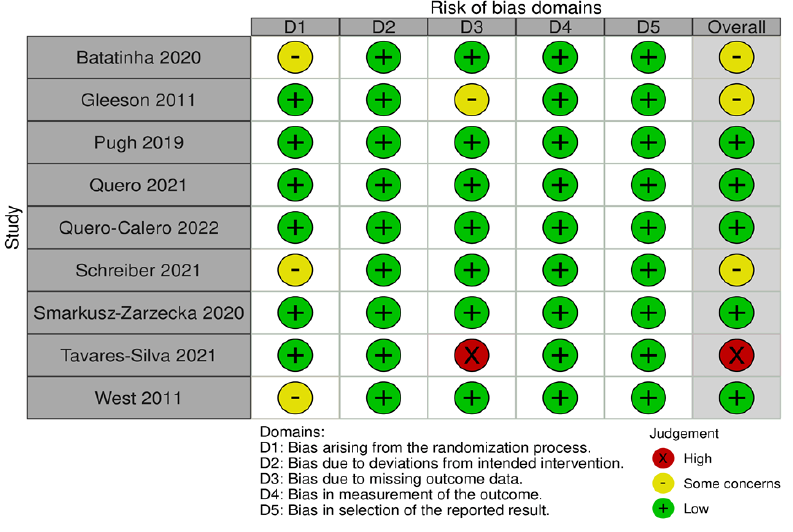
Figure 2. Flowchart of the risk of bias domains.